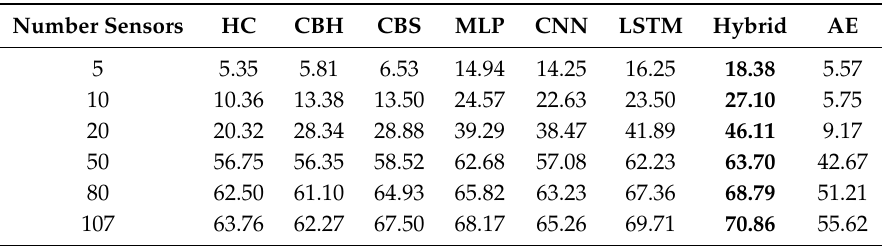
Table 6. Average F1-scores (in percent) of the feature learning models for different numbers of sensor channels on the OPPORTUNITY dataset.